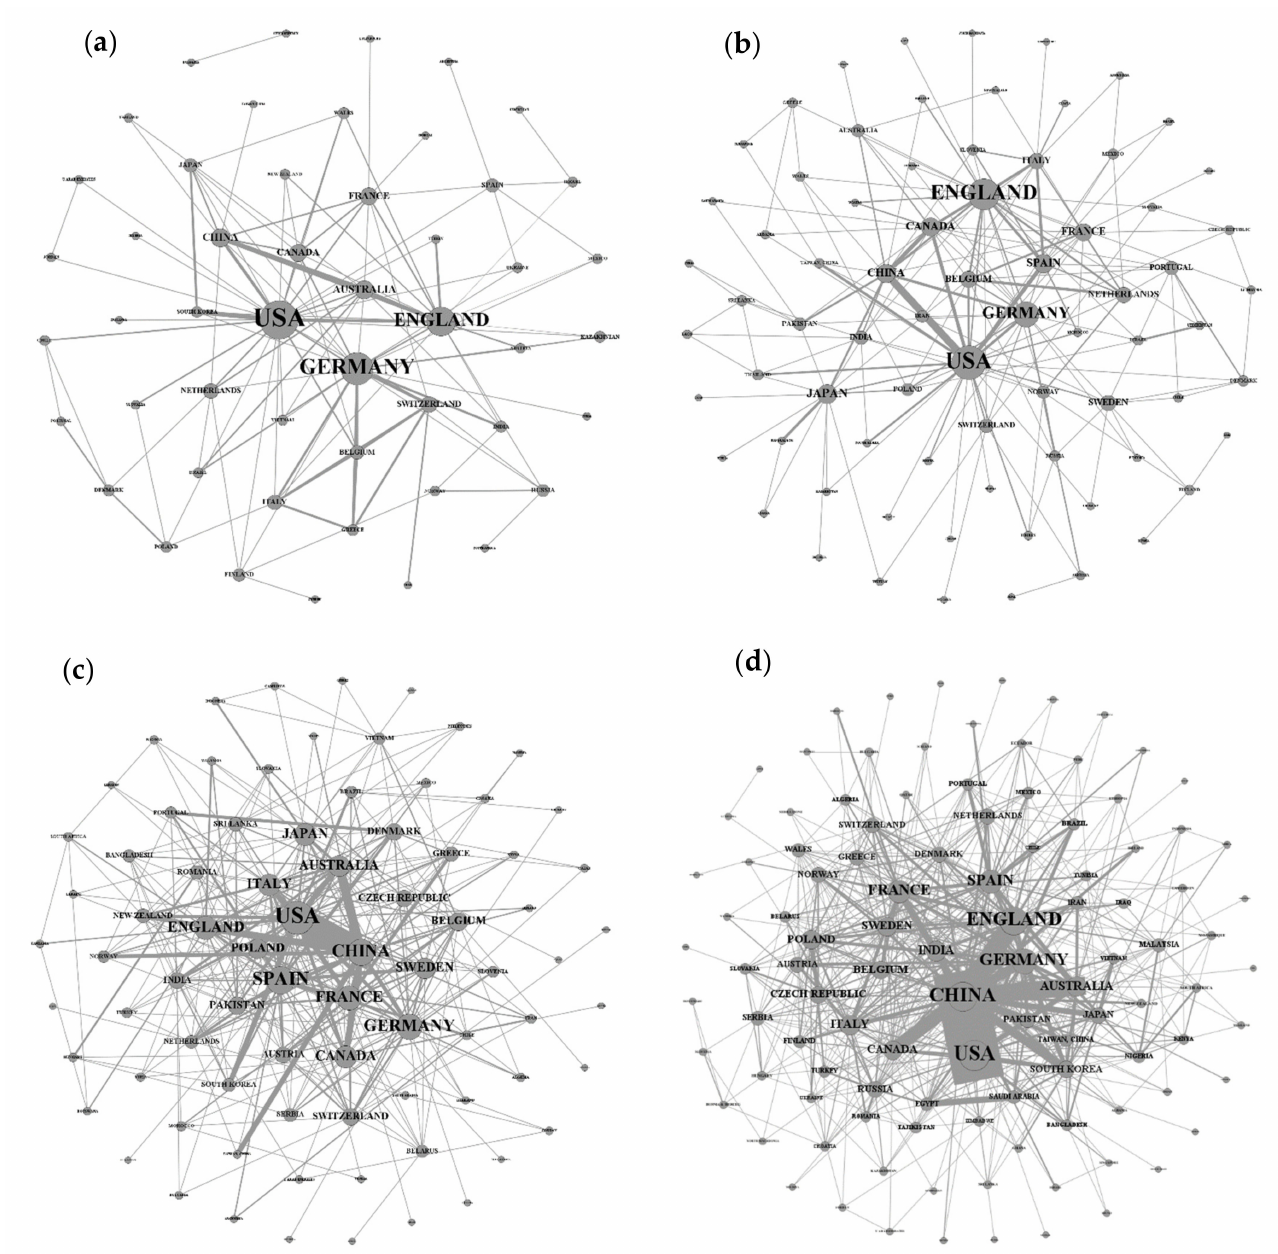
Figure 2. Map of co-occurrence of national cooperation: ( a ) 2001–2005, ( b ) 2006–2010, ( c ) 2011–2015, and ( d )